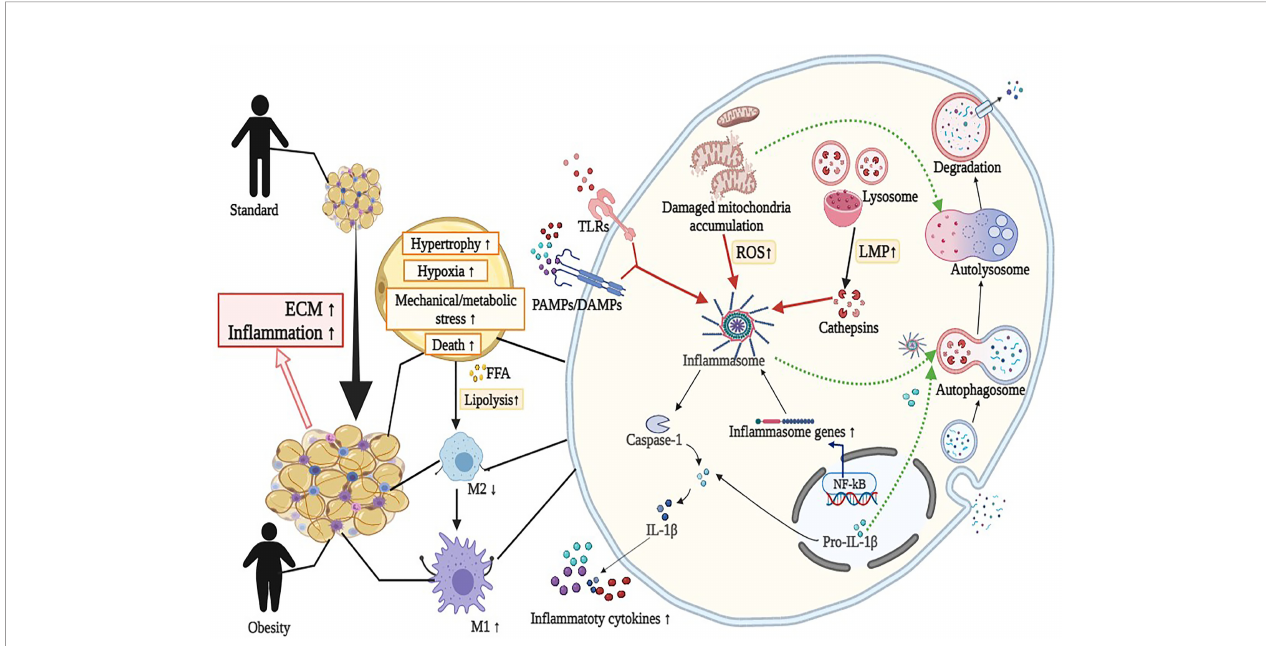
FIGURE 1 | Overview of the interaction between autophagy and NLRP3 in fl ammasome in adipose tissue in fl ammation (mainly adipocytes and macrophages). Activation of NLRP3 in fl ammasome by diverse metabolic stimuli (such as LPS, cathepsins, and mitochondrial dysfunction) via TLRs or PAMPs/DAMPs leads to metabolic and immune dysregulation, including insulin resistance, macrophage polarization (M2 to M1), hypoxia, impaired adipogenesis and increased fi brosis in adipose tissue. Detailed descriptions and explanations for each alteration can be found in Section 2 and Section 3. DAMPs, damage-associated molecular patterns; ECM, extracellular matrix; FFA, free fatty acids; IL-1 b , interleukin 1 b ; LMP, lysosomal membrane permeabilization; LPS, lipopolysaccharide; ROS, reactive oxidative species; PAMPs, pathogen-associated molecular patterns; TLRs, Toll-like receptors. Image created with